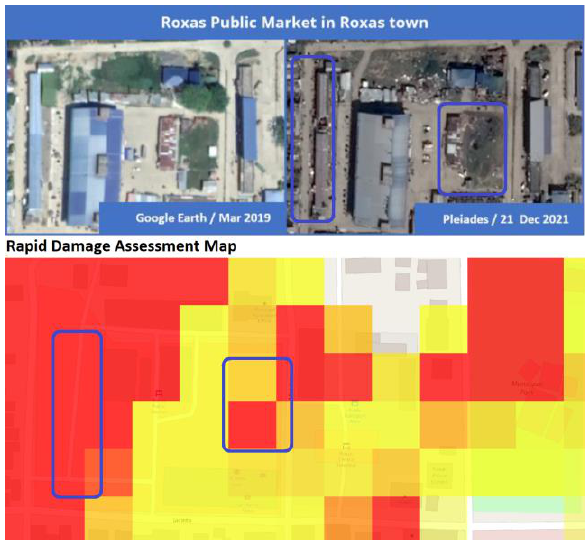
Figure 4. Damage assessment at Roxas City, Palawan. Bounding box indicates correspondence between the UNITAR/UNOSAT generated damage map and the rapid damage assessment map using SAR data. Basemap © OSM 2022.